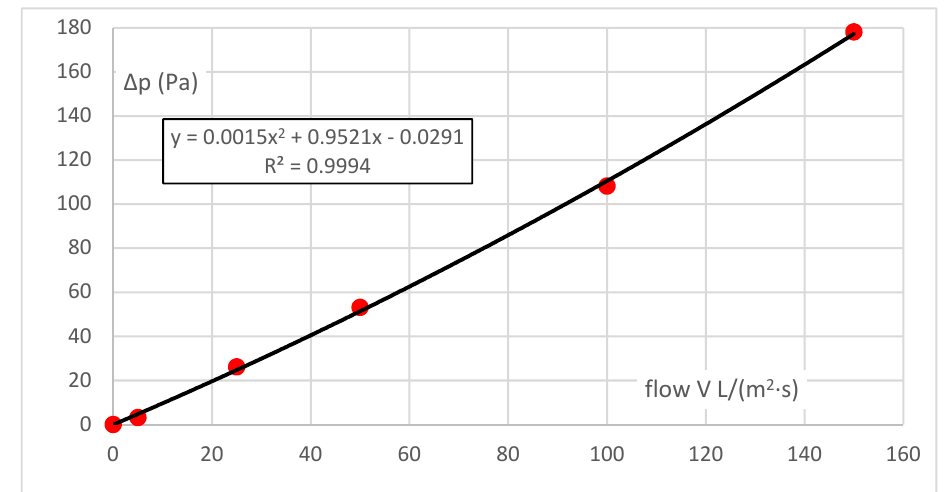
Figure 3. Water vapour flow at lower pressure difference.